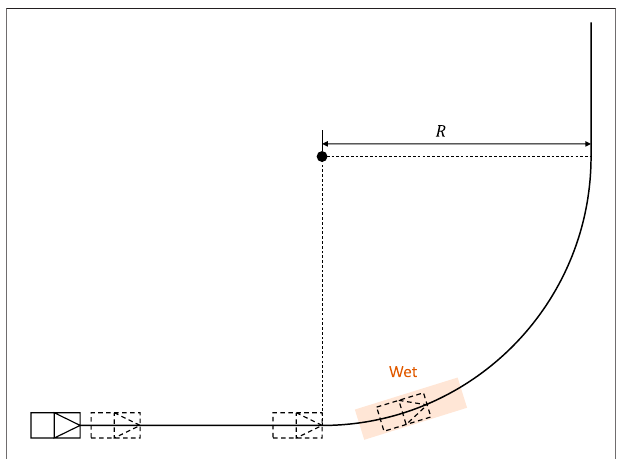
FIGURE 1 | Passing a sharp curve with water-covered